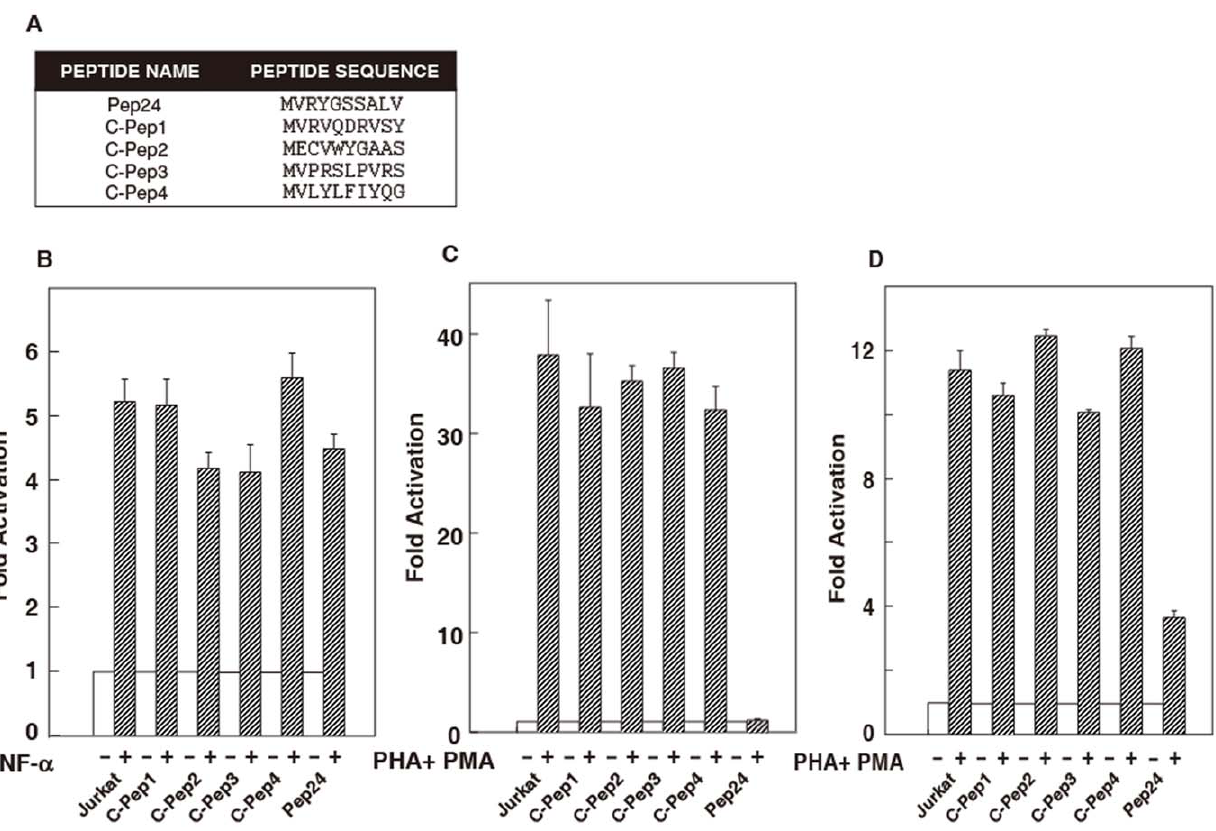
Figure 2. Selected peptide, Pep24, preferentially inhibits the NFAT signaling pathway. (A) The sequences of control peptides and selected peptide. (B–D) Reporter plasmids (B) p55-Ig k Luc, (C) NFAT Luc, or (D) AP-1 Luc were transfected into Jurkat cells expressing indicated peptides with pBMN LacZ as the internal control plasmid. Cells treated for 3 hr (8 hr for AP-1) with or without indicated agents (2 m g/ml PHA, 10 ng/ ml PMA, and 10 ng/ml TNF- a ) prior to measurement of luciferase activity. The experiments were repeated three times and the average is plotted 6 SE. Jurkat cells transfected with reporter without treatment were assigned a value of 1 and were used to calculate the fold activation. Transfection efficiencies were normalized to a co-transfected lacZ